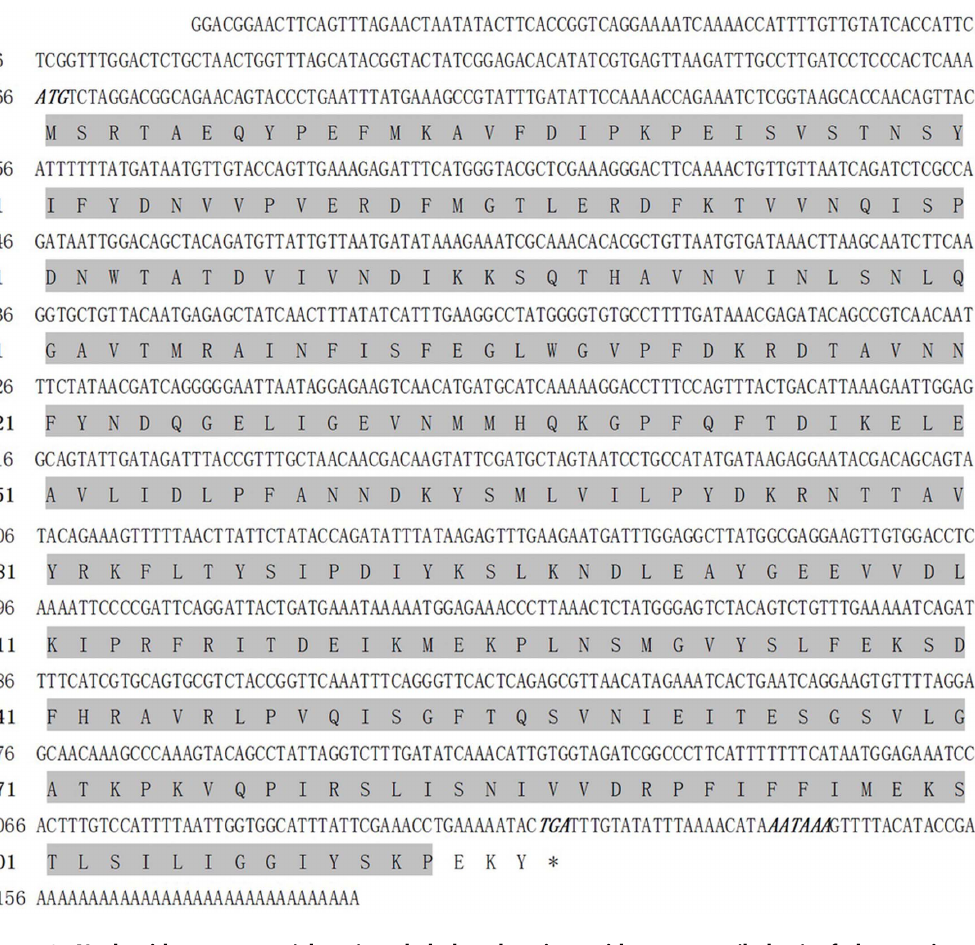
Figure 2. Nucleotide sequence (above) and deduced amino acid sequence (below) of the serpin-5 (GenBank accession No. KC505247). The serpin domain is shadowed. The asterisk (*) indicates the stop codon. Polyadenylation signal is bolded and italicized.